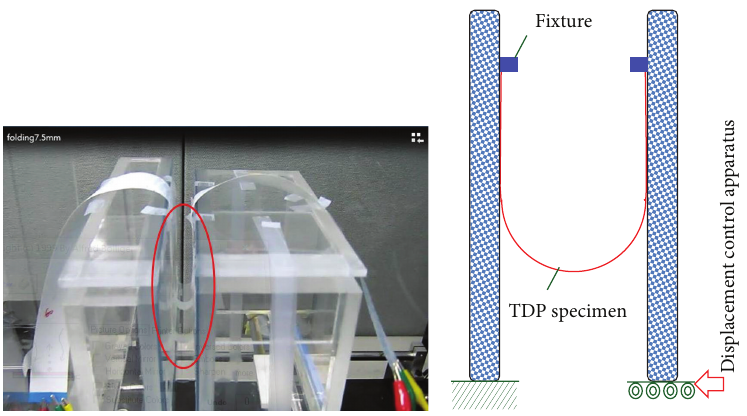
Figure 5: Two-point bending tester and test